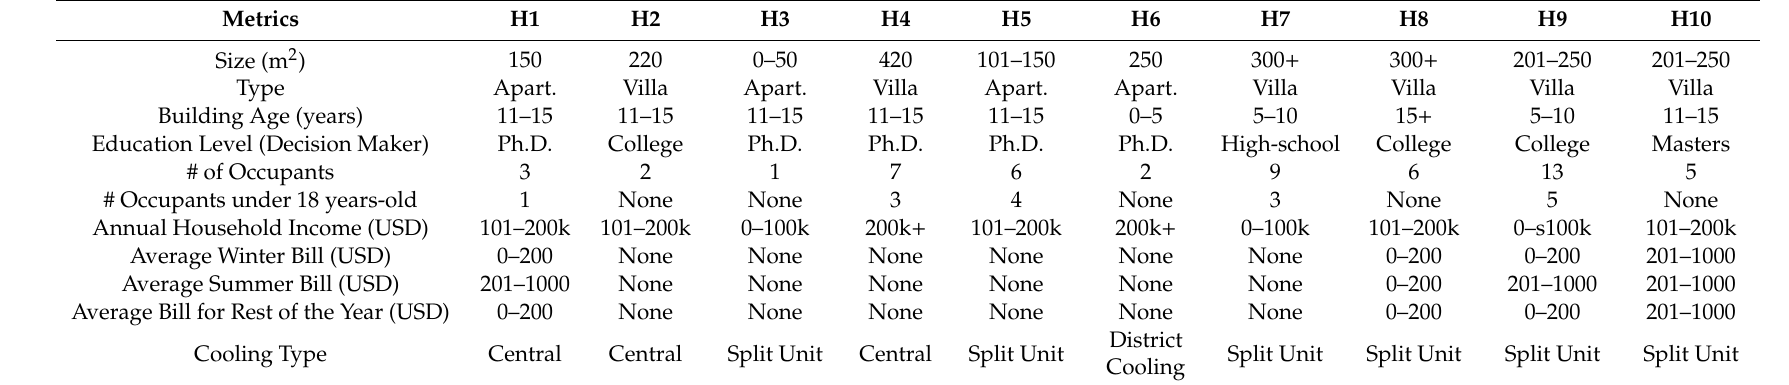
Table 4. Socioeconomic details of the electricity profiling study participants (H: